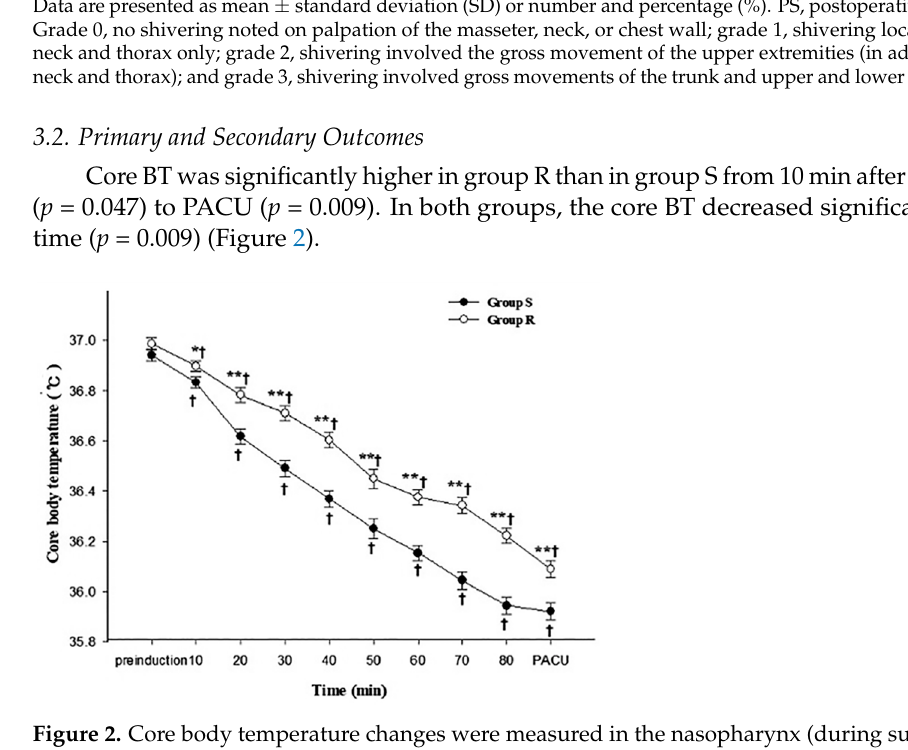
Meperidine administered for the treatment of PS 0.004 Data are presented as mean ± standard deviation (SD) or number and percentage (%). PS, postoperative shivering. Grade 0, no shivering noted on palpation of the masseter, neck, or chest wall; grade 1, shivering localized to the neck and thorax only; grade 2, shivering involved the gross movement of the upper extremities (in addition to the neck and thorax); and grade 3, shivering involved gross movements of the trunk and upper and lower extremities.